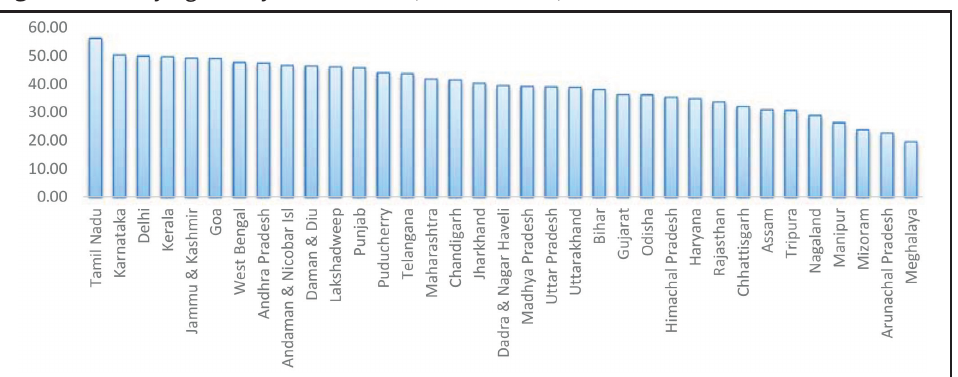
Figure 4 AI by age ≥60 years in India (LASI-2017-18).